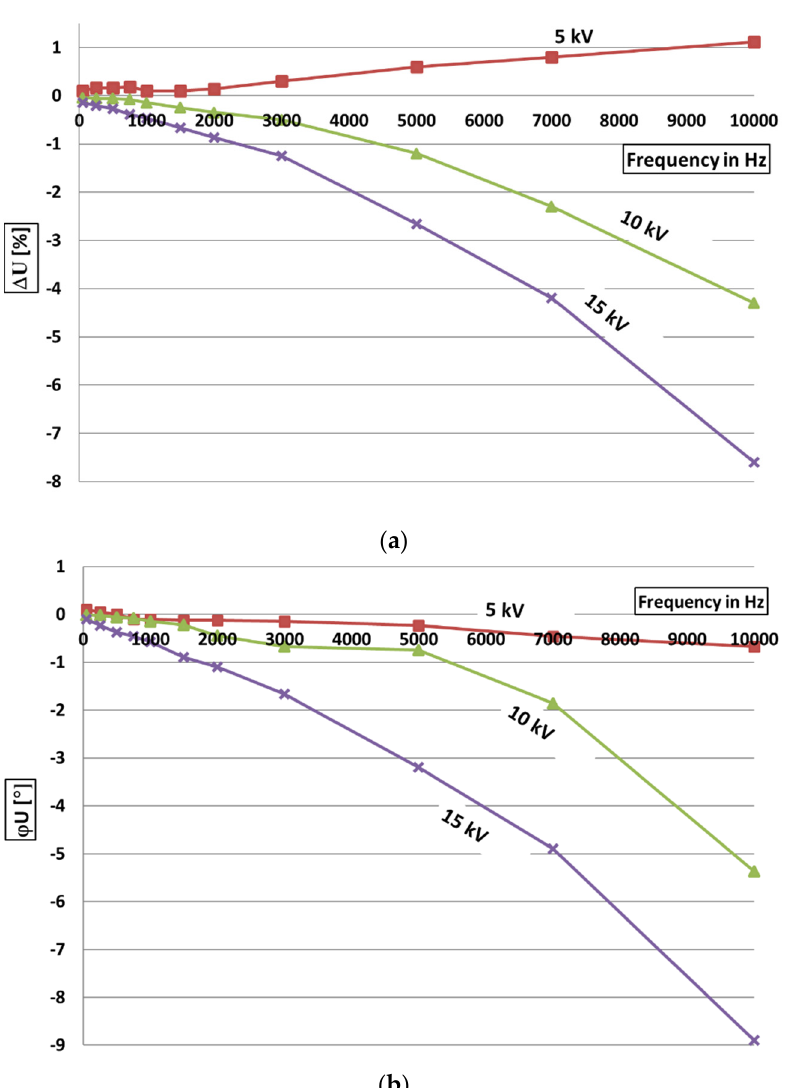
Figure 8. ( a ) Voltage ratio error of tested voltage divider at three ranges. ( b ) Phase error of tested voltage divider at three ranges.